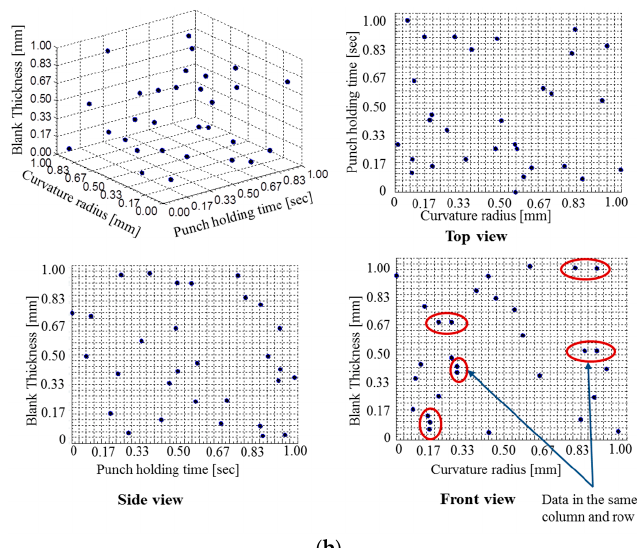
Figure 7. Training and testing sample data of the model: ( a ) Training data using Latin hypercube sampling; and ( b ) Testing data using random sampling.